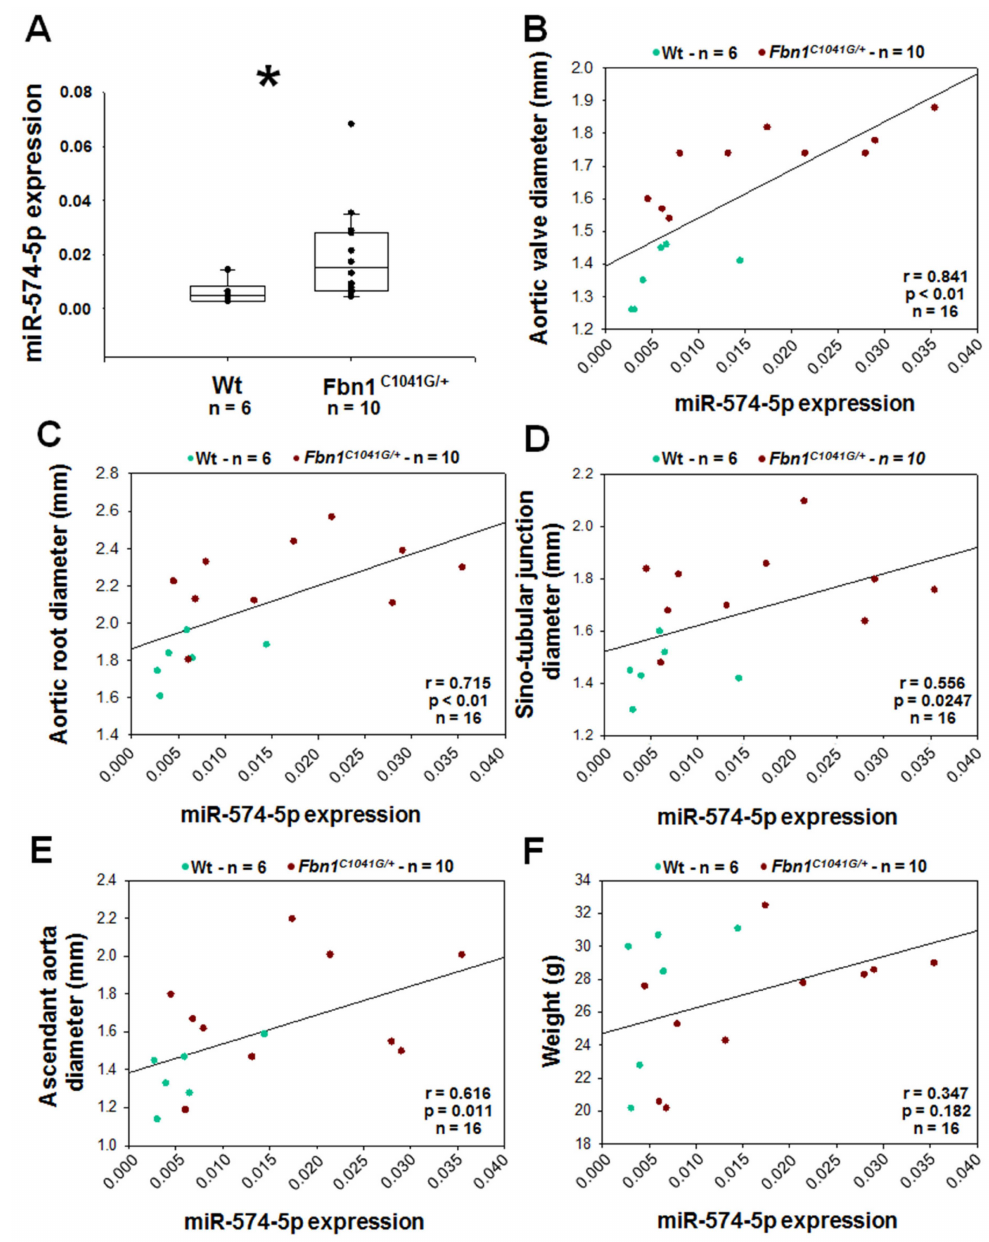
Figure 6. Association between plasma levels of miR-574-5p and aortic dilatation in Fbn1 C1041G /+ mice. ( A ) Expression of miR-574-5p in the plasma of Fbn1 C1041G /+ and wild-type (Wt) mice. ( B – F ) Spearman correlation between miR-574-5p and, respectively, the aortic valve diameter ( B ), aortic root diameter ( C ), sino-tubular junction diameter ( D ), ascendant aorta diameter ( E ) and weight ( F ). R = correlation coe ffi cient; * p < 0.05; among the 16 mice, six are females (two Wt and four Fbn1 C1041G /+